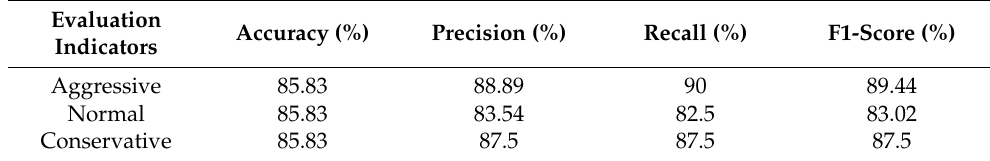
Table 17. Various evaluation indicators of the FOA-GRNN driving propensity identification model.